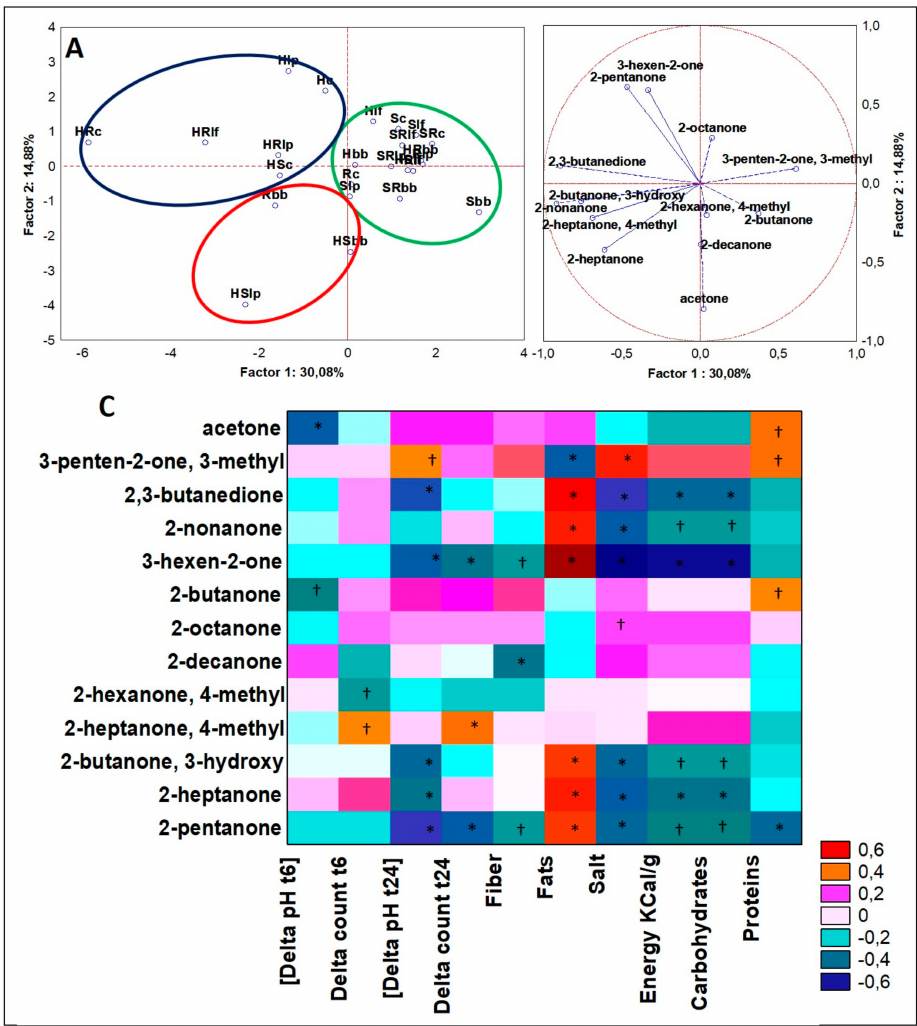
Figure 5. ( A ) PCA of cases and ( B ) variables on ketones; c) Spearman rank correlations on ketones. * p < 0.01; † p < 0.05. For samples abbreviations see Figure 1. Figure 5A: cluster 1 = blue line; cluster 2 = red line; cluster 3 = green line.3.4.4.